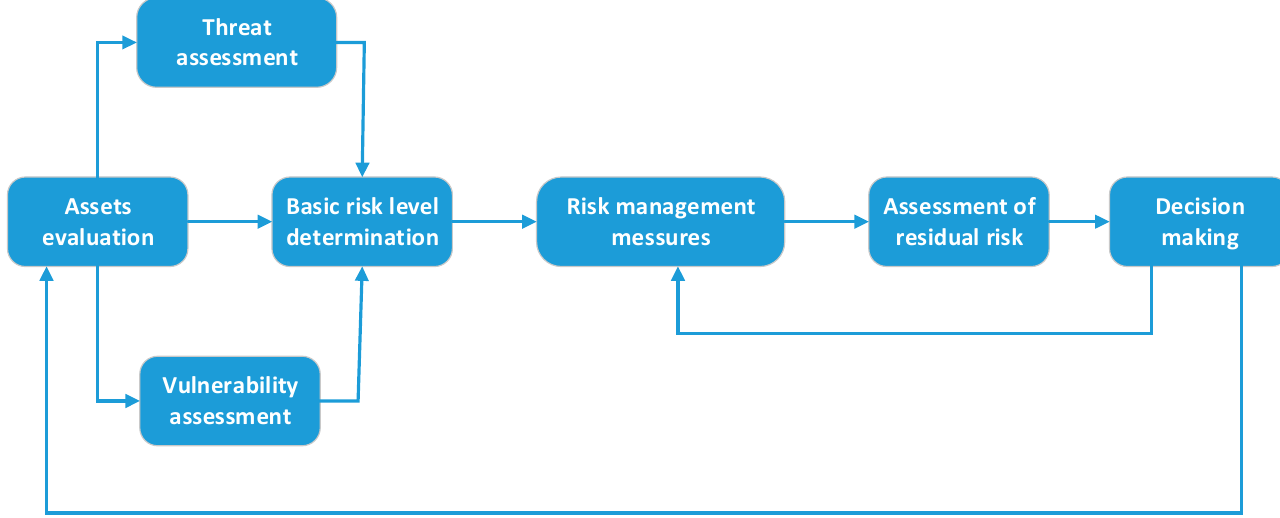
Figure 3. The basic risk assessment process.